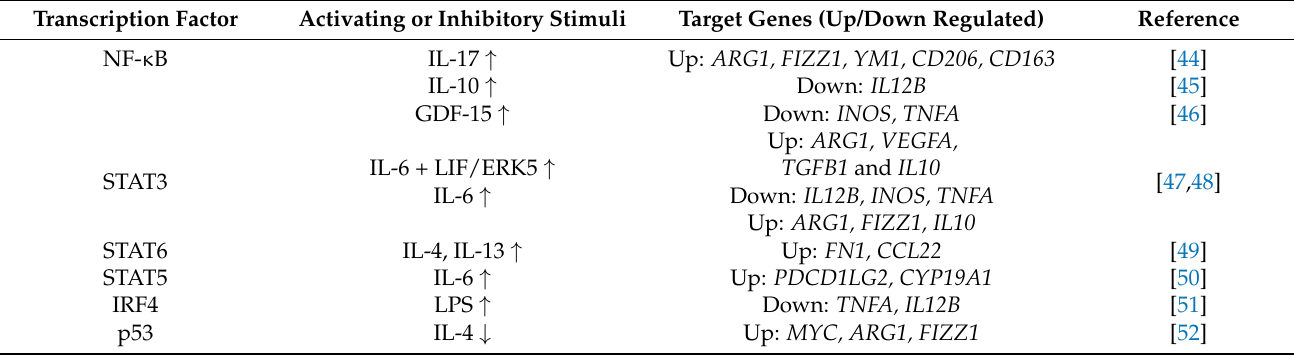
Table 2. Major transcription factors involved in anti-inflammatory macrophage